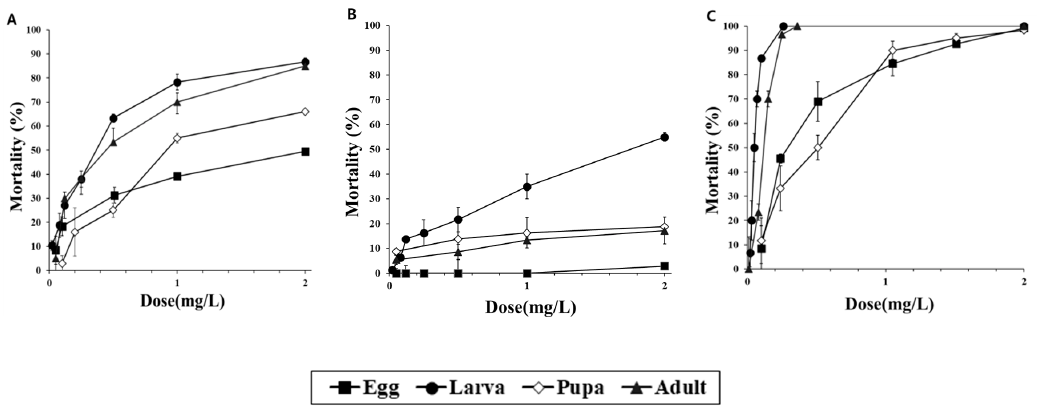
Figure 1. Mortality of ( A ), d-strain Tribolium castaneum , ( B ), r-strain T . castaneum and ( C ), Oryzaephilus surinamensis eggs, larvae, pupae and adults after 4 h of exposure to the PH 3 fumigant in a 12-L desiccator.